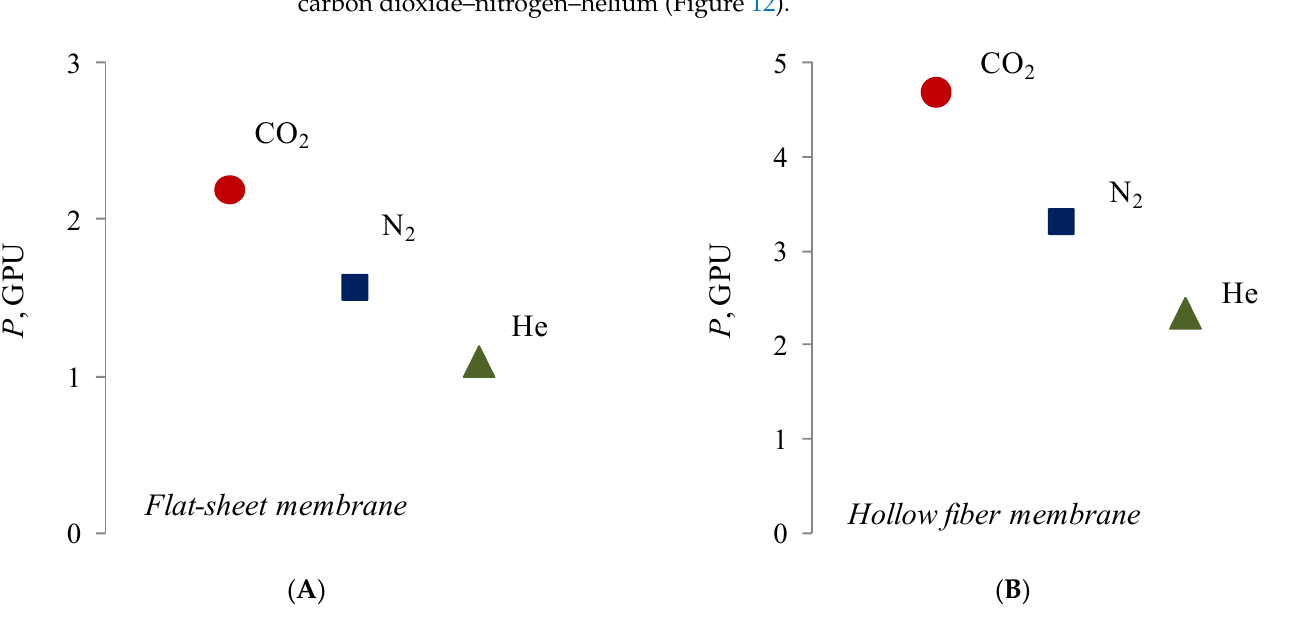
Figure 12. Permeability of flat ( A ) and hollow-fiber ( B ) composite membranes with a silver alginate selective layer for pure gases. Thickness of Alg-Agis 20 µm.